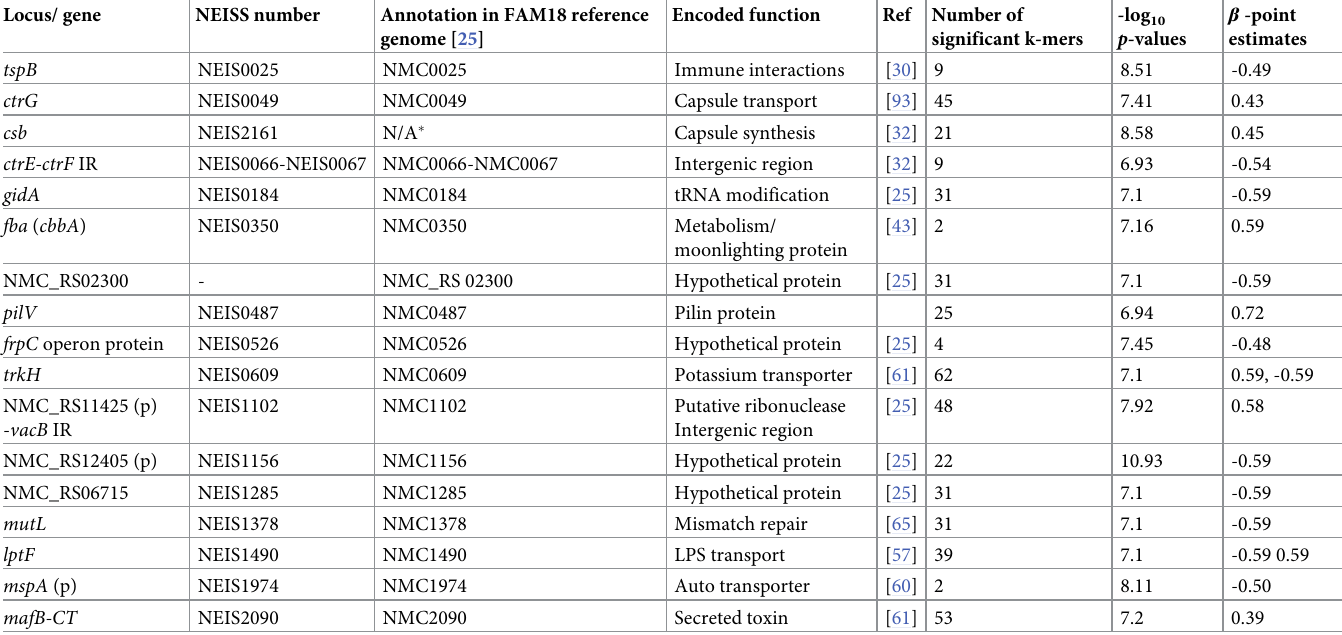
Table 1. Summary of significant k-mer associations. The number of significant kmers, most significant -log 10 p -values and β point estimates for the most significant kmers for each gene. (p) denotes pseudogenes, IR = intergenic region. � N/A: not applicable as FAM18 is a serogroup C isolate and this locus is occupied in FANM18 by polysialyl-transferase gene csc